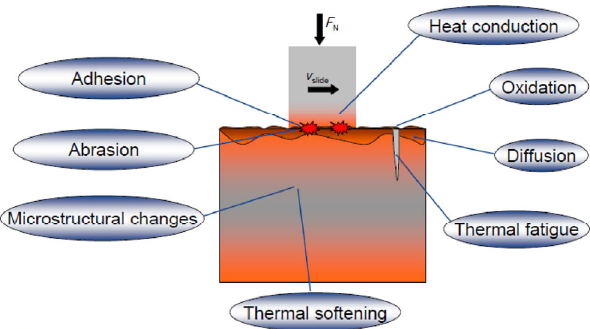
Fig. 21 Schematic showing the complexity of a sliding contact at elevated